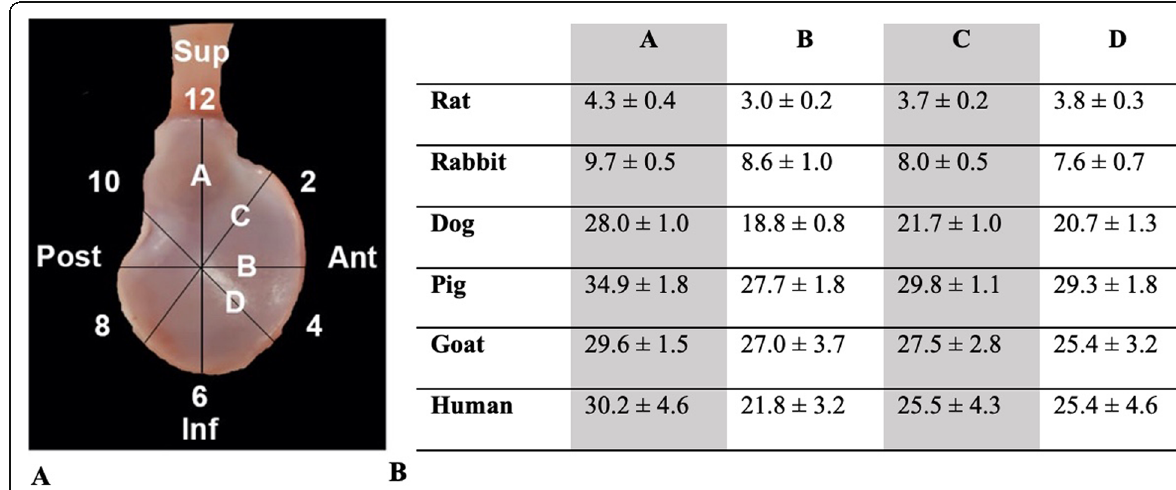
Fig. 2 A Glenoid clockface positions with B linear dimensions (in